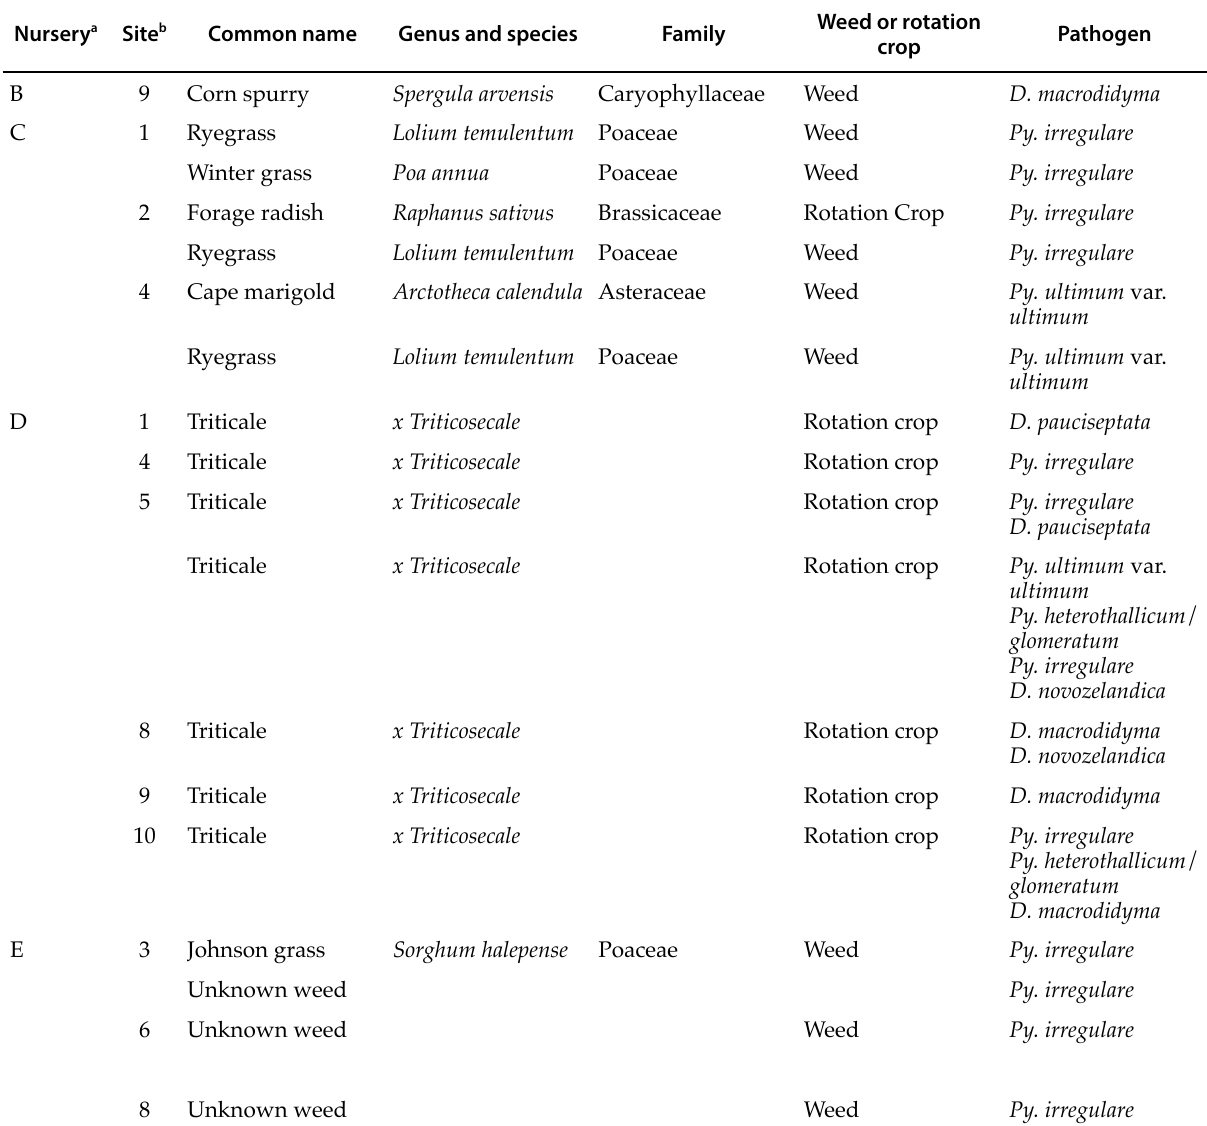
Table 3. Pathogens isolated from weeds and rotation crop plants sampled from four grapevine nurseries in 2014. Nursery a Site